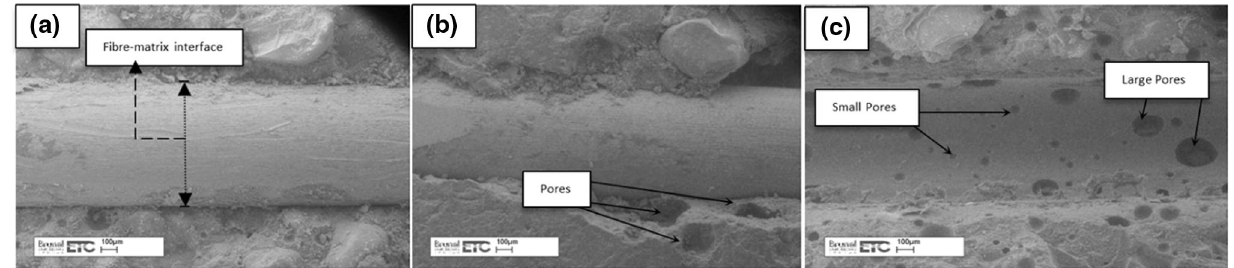
Fig. 10 SEM images of the fibre-matrix interface. a UHPM1(W/B = 0.15), b UHPM2 (W/B = 0.20) and c UHPM3 (W/B =